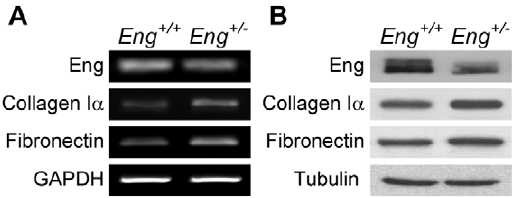
Figure 3. Effect of endoglin haploinsufficiency on extracellular matrix formation. ( A ) Synthesis of collagen I a and fibronectin by Eng + / + and Eng + / 2 MDF were analyzed by RT-PCR. GAPDH was used as housekeeping ( B ) Synthesis of collagen I a and fibronectin were also evaluated by western blot in total protein extracts from Eng + / + and Eng + / 2 MDF using Tubulin as loading control. A representative blot from three independent experiments is